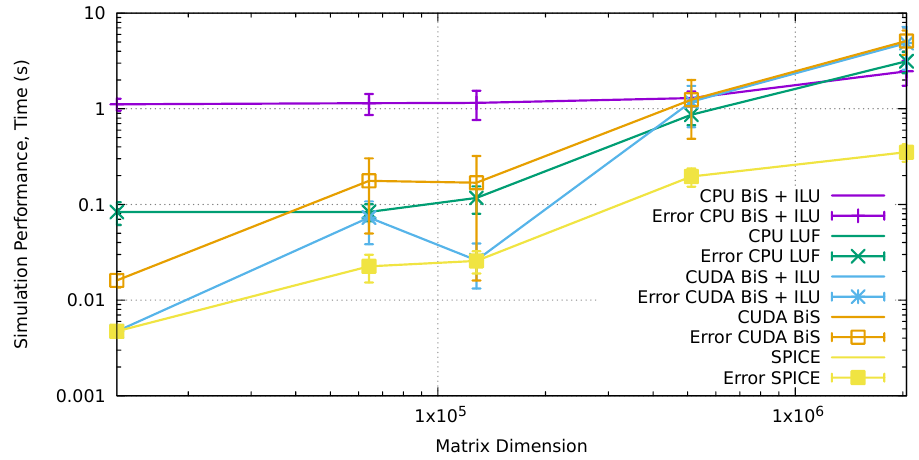
Figure 4. Simulation Performance, Time